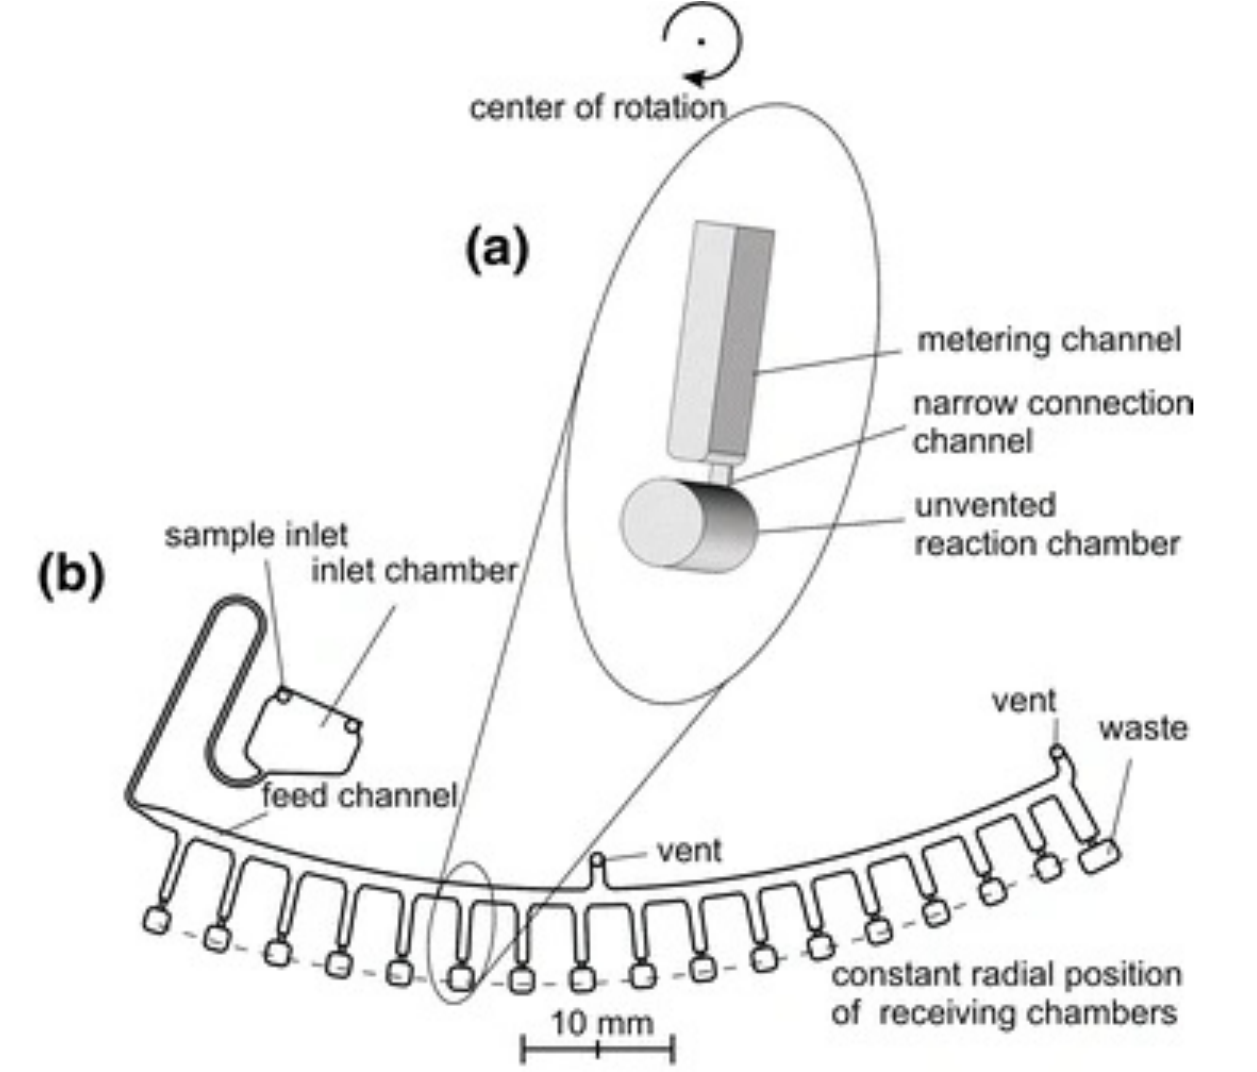
Figure 7. Layout and functional principle of the centrifugo-pneumatic valve and the aliquoting structure. ( a ) The 3D image shows a view on a single metering structure. ( b ) A radially inclined feed channel supports several branching metering structures. Permission granted by the publisher [36].